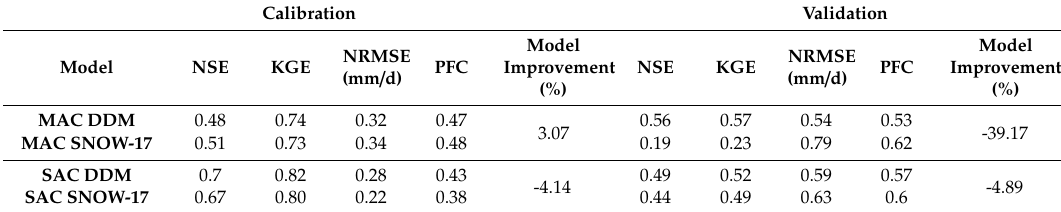
Table 4. Annual model performance statistics for UASR.